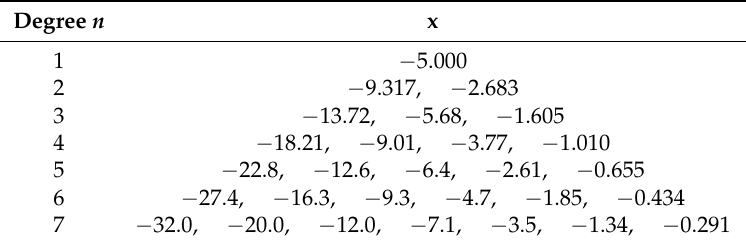
Table 2. Approximate solutions of G n ( x , r , β ) = 0, x ∈ R